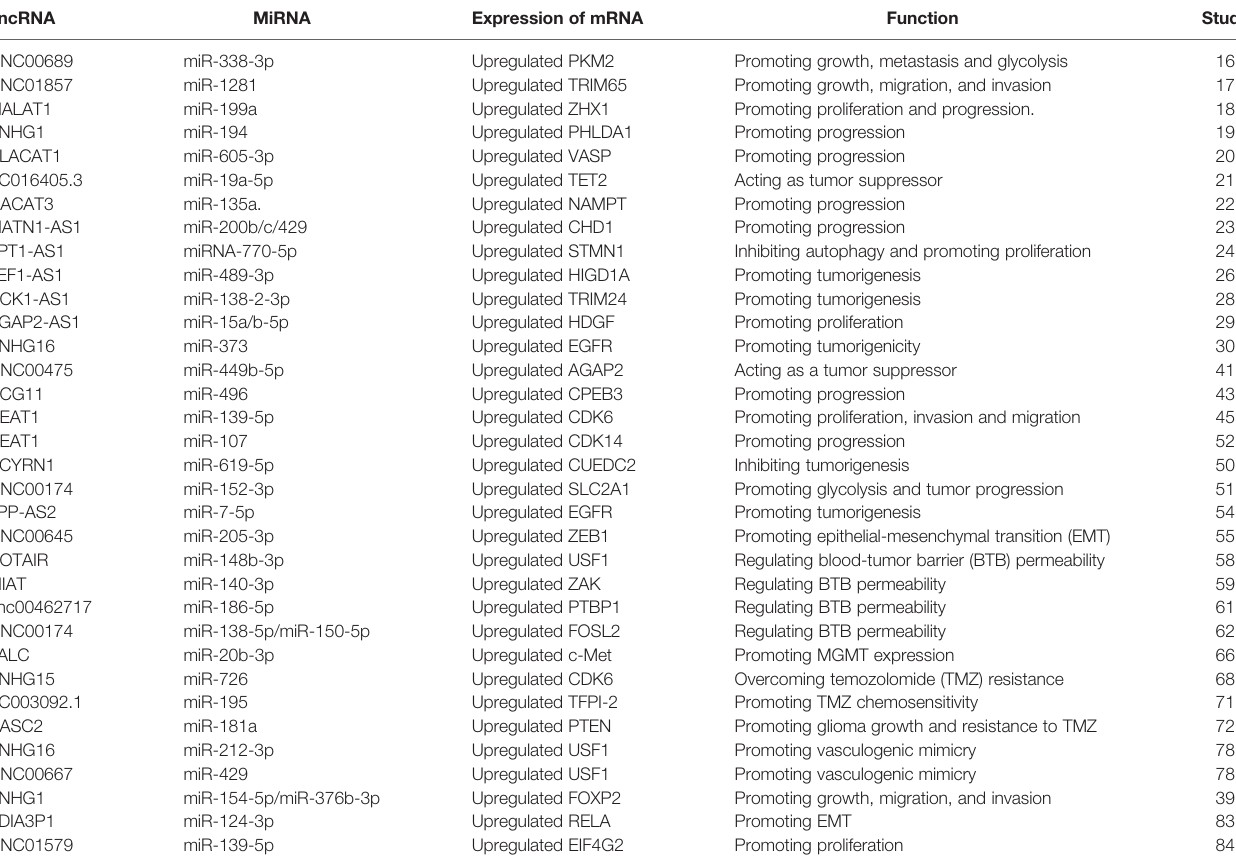
TABLE 1 | The role of lncRNAs as ceRNA in the